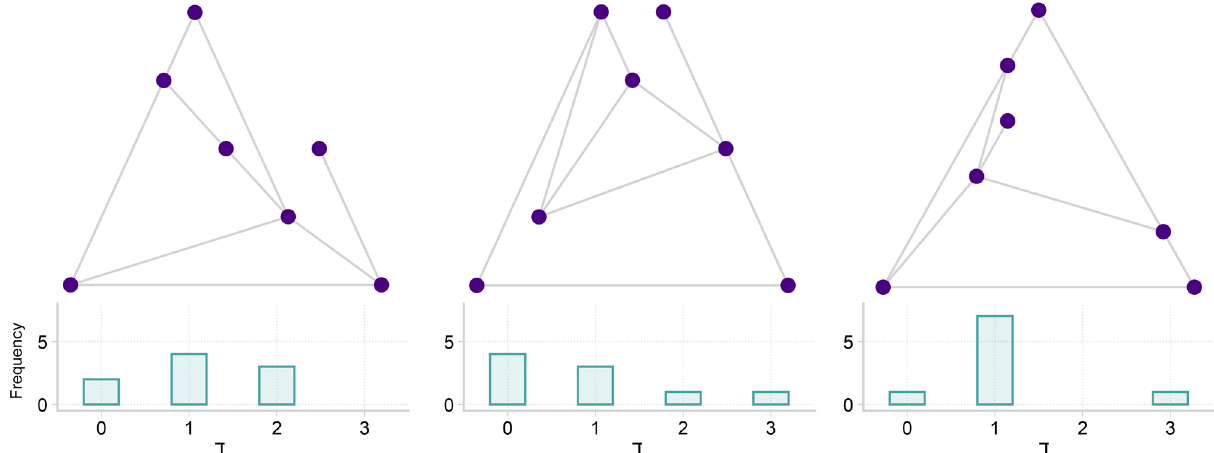
Figure 2. Graphs with same degree sequence and same global assortativity (GA) can have different degree difference (DD) distributions. The figure shows 3 graphs with 7 vertices and 9 edges with same degree sequence and GA of ≈ − 0.358 , but with different DD distributions. In the figure, the bar plot below each graph shows the DD